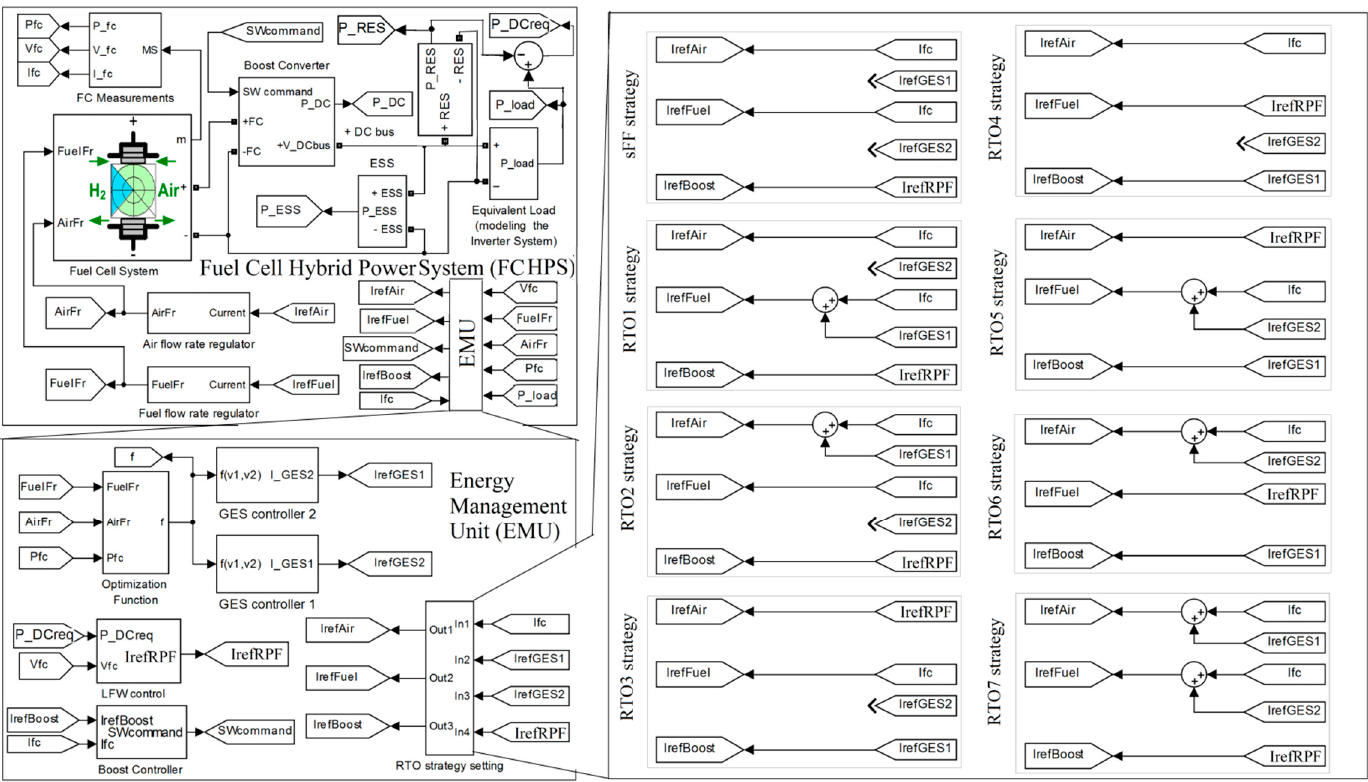
Figure 1. The Fuel Cell Hybrid Power Systems (FCHPS), Energy Management Unit (EMU) and RTO strategy setting block.